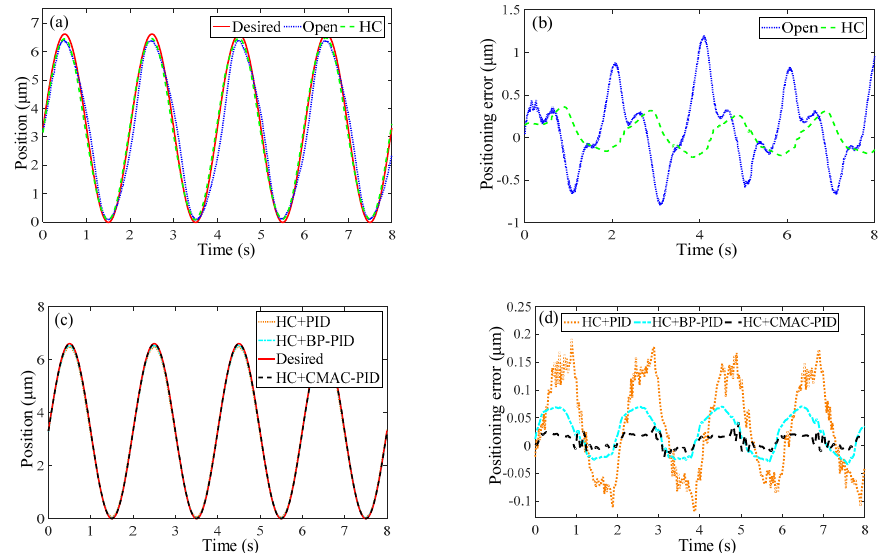
Figure 11. Experimental motion tracking results of micro-positioner for the translational motion along X / Y axis: ( a , b ) feedforward compensation, ( c , d ) feedback